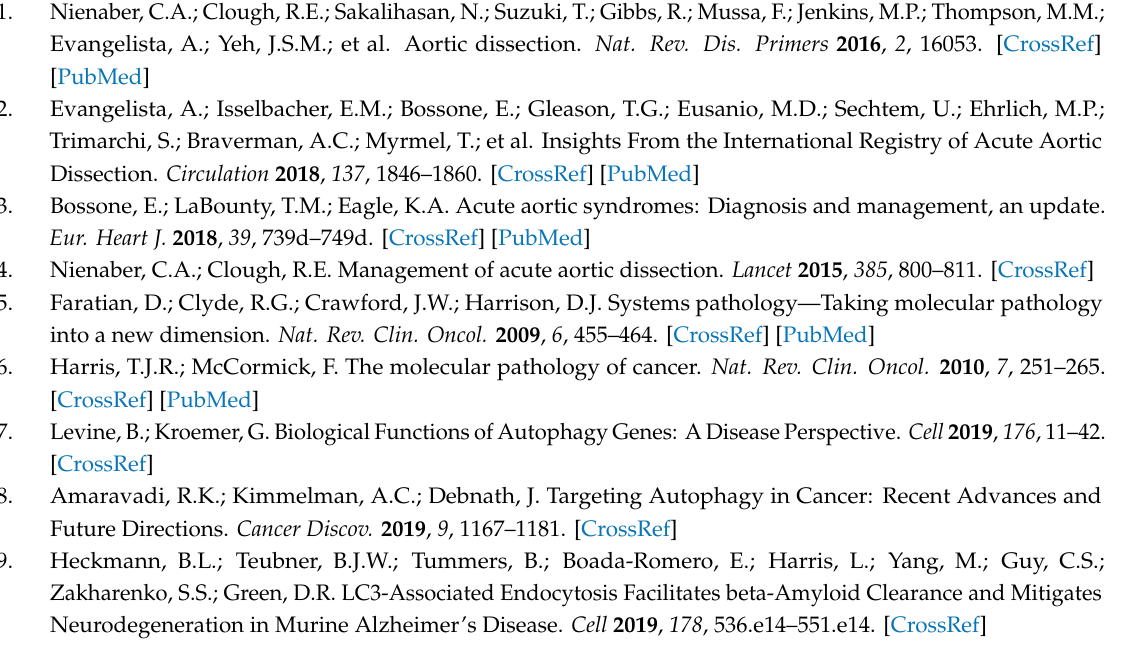
Figure S1: Volcano plot, all di ff erentially expressed autophagy-related genes (DEARGs) were labeled in the plot. Figure S2: The same PPI network as Figure 5A with lager version. Figure S3: Gene modules and related genes, the same as Figure 5B with lager version. Figure S4: Crosstalk between gene function and signaling pathway, the same as Figure 5E with lager version. Figure S5: qPCR validation of hub genes. Data was expressed as Table S2: The list of quantitative PCR primers. Table S3: The list of all Differentially Expressed Genes (DEGs) from our datasets. Table S4: The list of Aytophagy-related genes (ARGs) obtained from the Autophagy Database and the Human Autophagy Database. Table S5: The list of Differentially Expressed Aytophagy-related genes